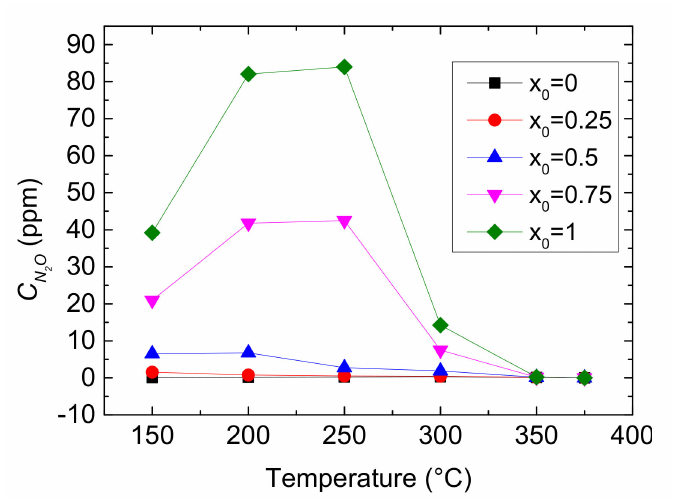
Figure 6. Outlet C N2O as different x 0 values and reaction